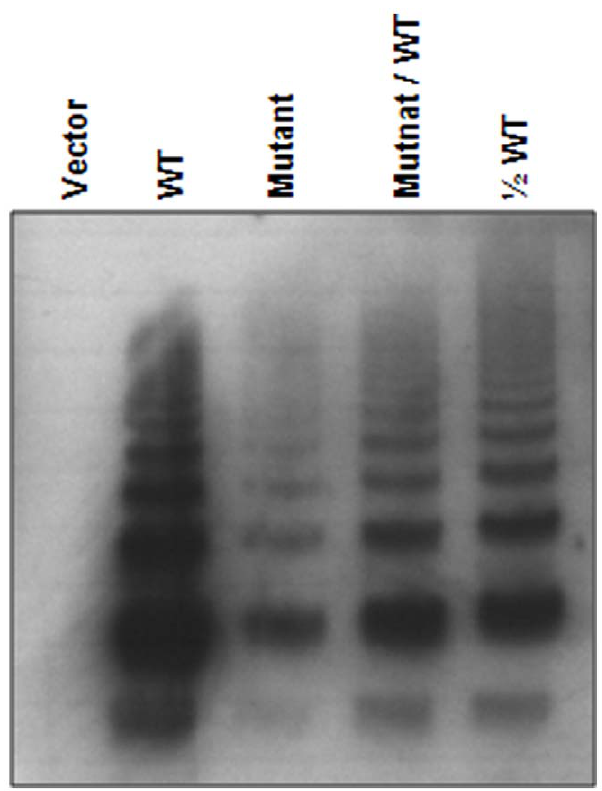
Figure 4. Multimer analysis of recombinant VWF expressed in HEK293 cells. Multimeric analysis of recombinant VWF was performed with the conditioned medium from HEK293 cells transfected with plasmids for WT and the mutant, individually or in combination. Samples from the vector-transfected cells were used as a negative control.